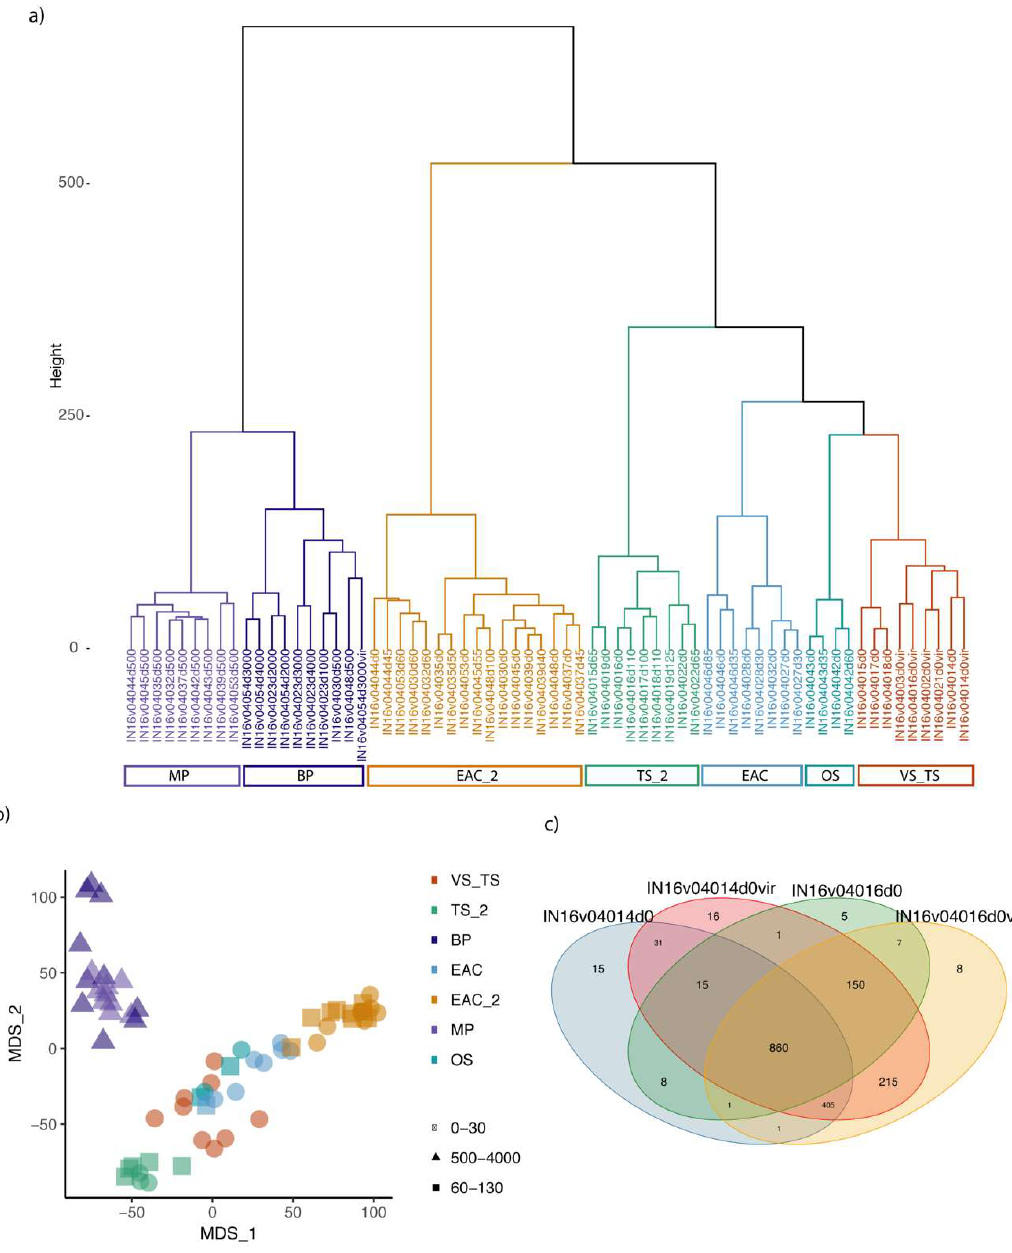
Figure 3. ( a ) Hierarchical clustering of sites based on the normalized abundance of large viral contigs ( n = 624). A SIMPROF analysis based on Bray–Curtis dissimilarity index was used to identify seven significant clusters. The relative abundance of viral contigs was normalized based on reads count and square root transformed. Sites are color-coded bases on significant clusters. VS_TS = Virome and surface Tasman samples, TS = Tasman Sea surface and DCM, EAC and EAC_2 = EAC, Tr_M and S.N, OS = Offshore samples from Tr_M, MP = Mesopelagic samples (500 m), BP = Bathypelagic samples and virome samples. ( b ) Non-metric multidimensional scaling plot of the bacteriophage diversity observed in the first two axes for all the stations and depths. Samples are color-coded based on hierarchal clusters calculated from the SIMPROF test (Clustsig). Shapes are related to different depth ranges. ( c ) Venn diagram showing the distribution of shared and unique viral contigs in the microbial fraction (>0.2 µm) (INv04014d0, IN16v04016d0) and the viral fraction (< 0.2 µm) (INv04014d0vir, IN16v04016d0vir), from the same sites.